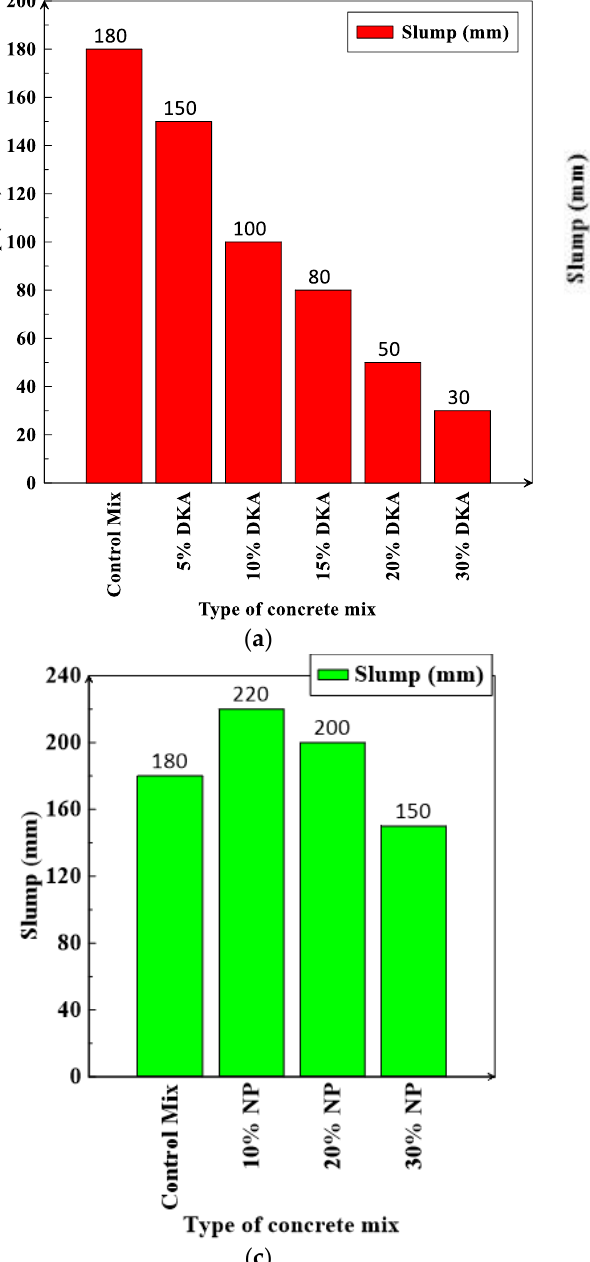
Figure 14. Slump of concrete mixes containing ( a ) DKA, ( b ) FA, and ( c ) NP.